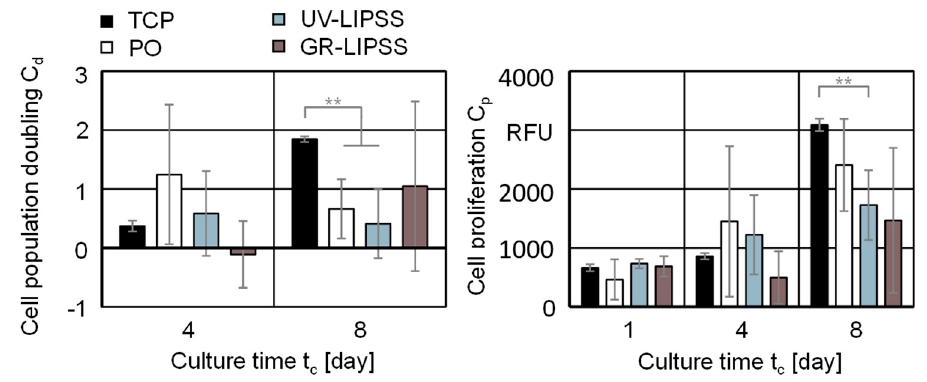
Figure 6. Cell population doubling C d and cell proliferation C p on TCP, PO, UV-LIPSS, and GR-LIPSS. Statistical analysis by ANOVA and Tukey’s test for determination of statistically significant differences (n = 5 each group, ** for p < 0.01).